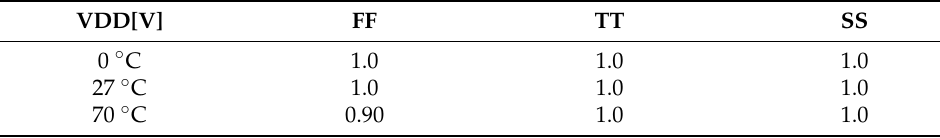
Figure 5. ( a ) Simulated V REF vs. V DD and ( b ) I DD vs. V DD . Table 1. Simulation result of V DD at corner